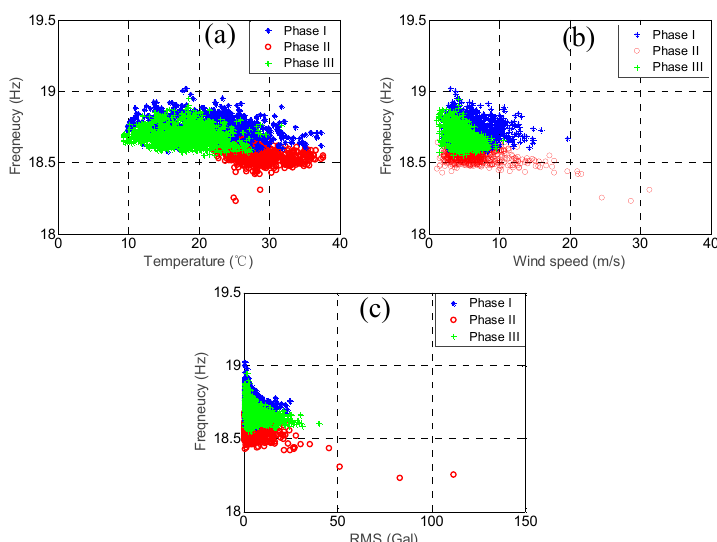
Figure 17. The relationship between the 7th modal frequency (18.67Hz) and ( a ) temperature; ( b ) wind speed; and ( c ) RMS acceleration.